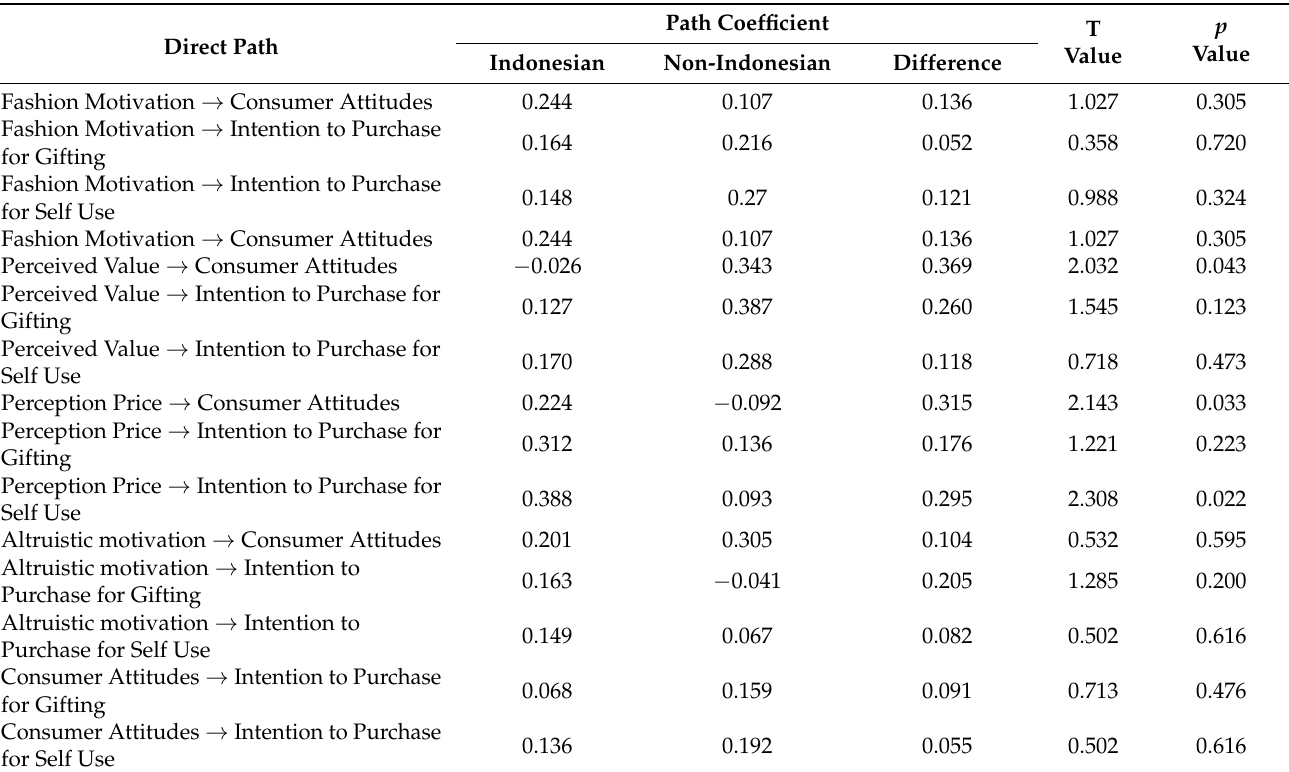
Table 4. Multi-group hypothesis